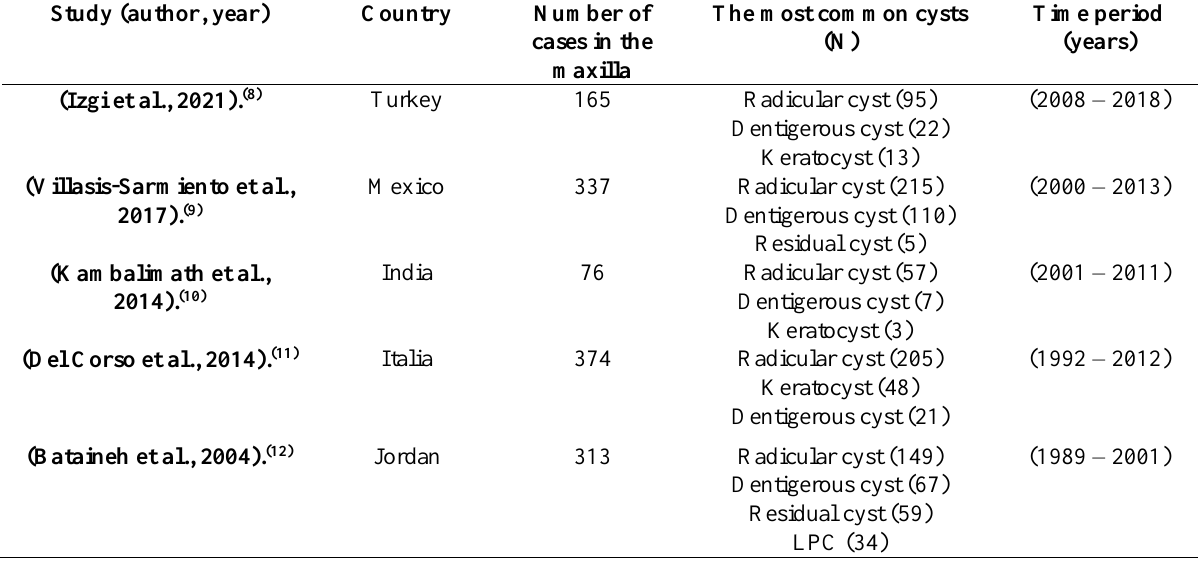
The most common cysts Time period cases in the (N) maxilla